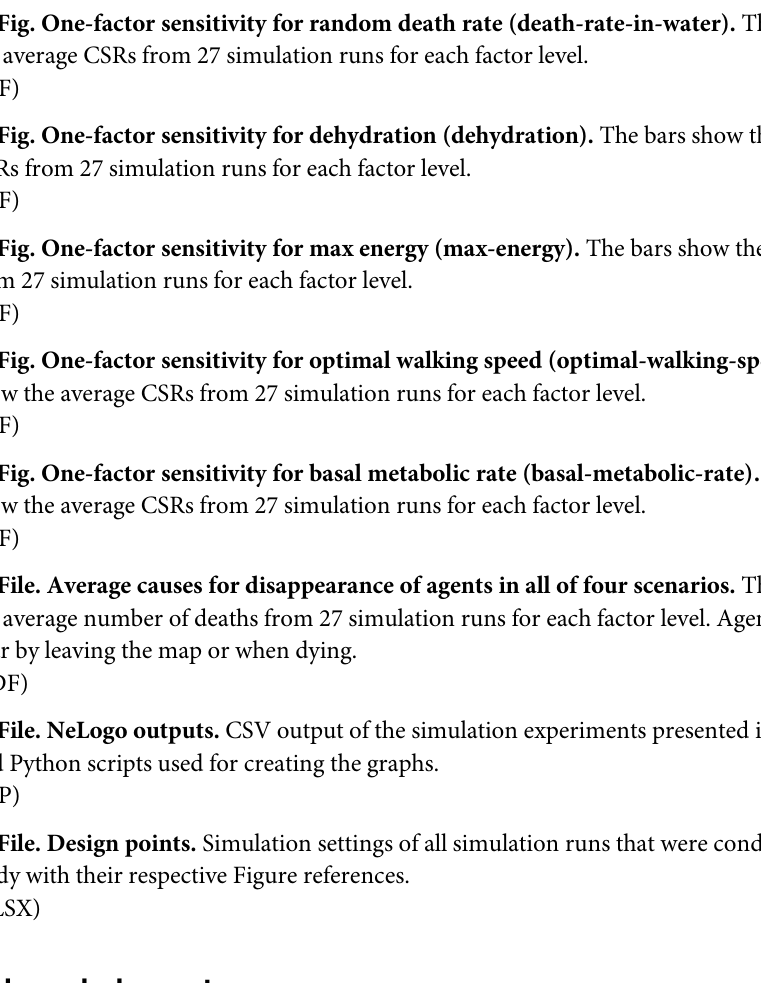
show the average CSRs from 27 simulation runs for each factor level.